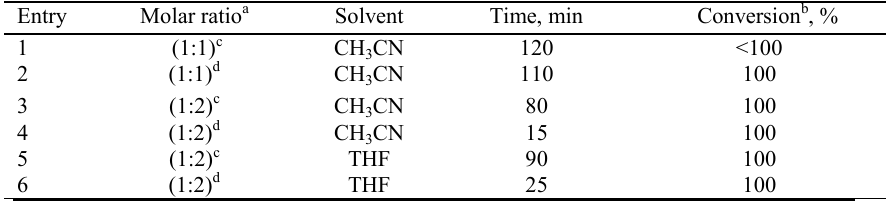
Table 2. Optimization Reaction Conditions of Reduction of Acetophenone